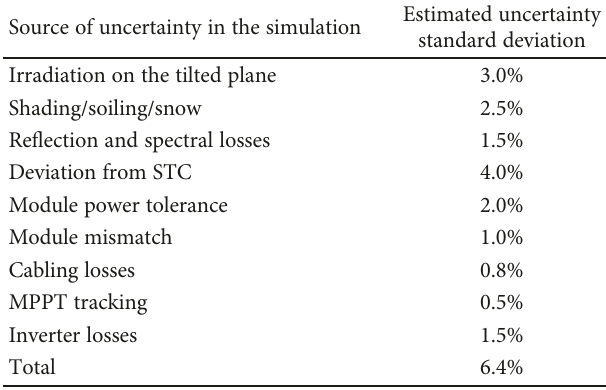
Figure 8: First month AC ohmic loss and external transformer loss. Table 9: The above sources assessed for the project and are presented in the table.